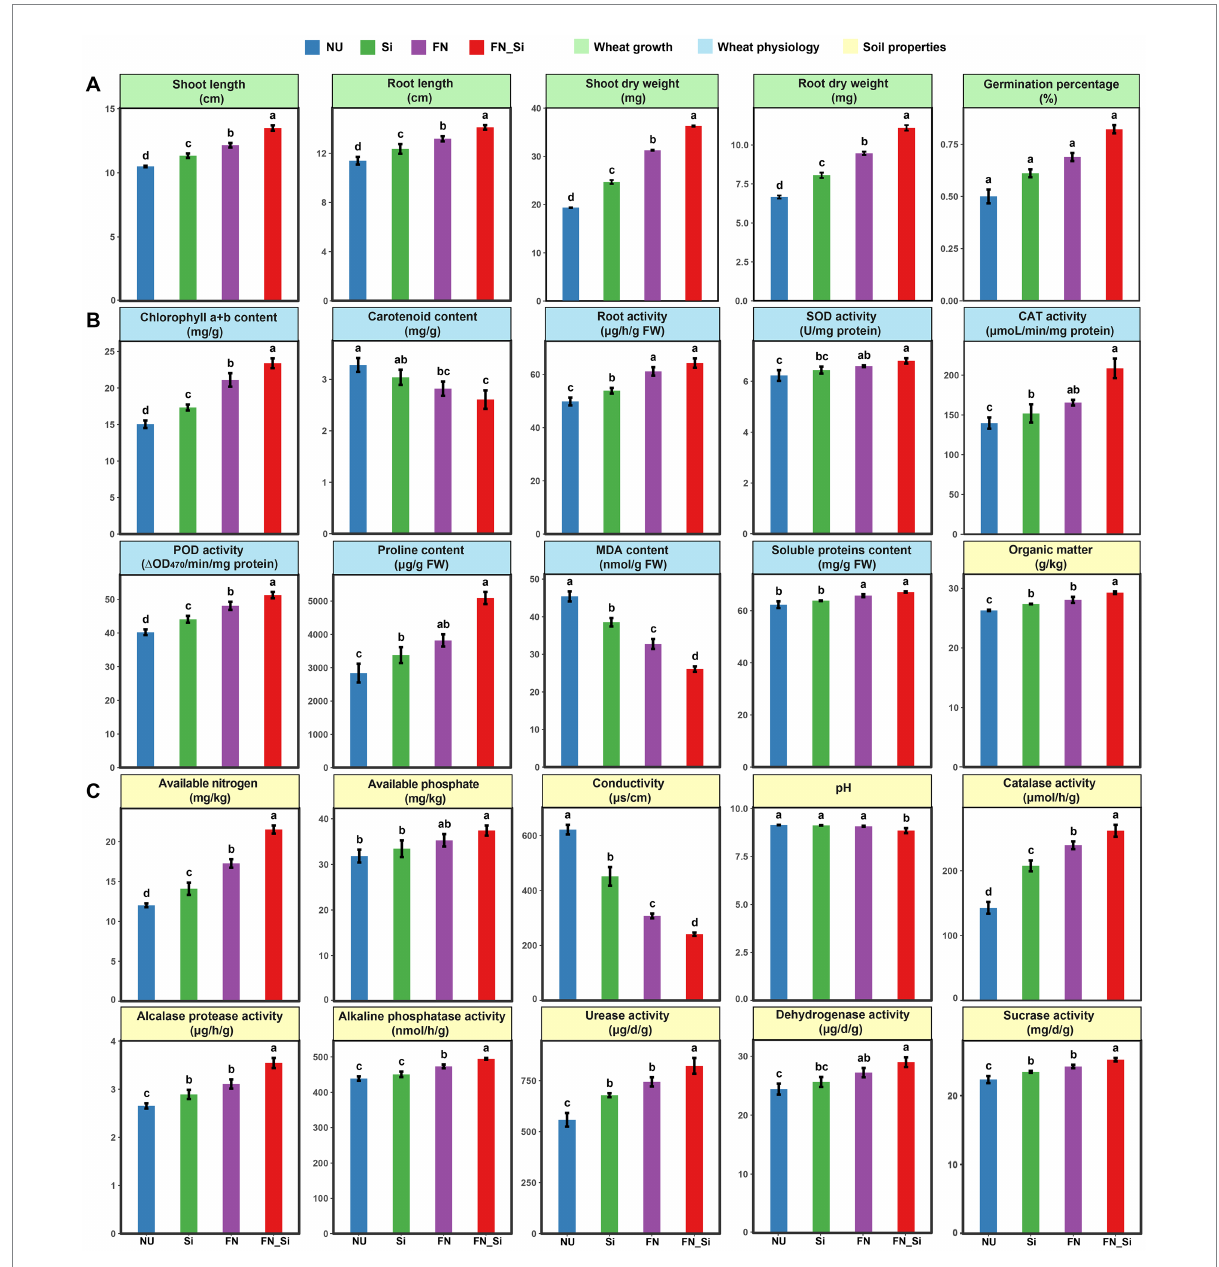
FIGURE 2 (A) Wheat growth, (B) wheat physiology, and (C) soil properties. Error bars indicate the SD from the mean among treatments. Letters indicate significant differences at p <